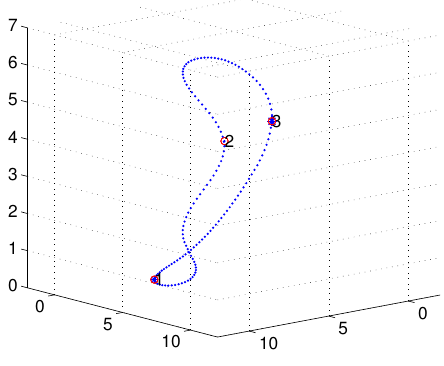
Figure 9. Three-dimensional (3D) Bezier interpolation results with n = 3 nodes.